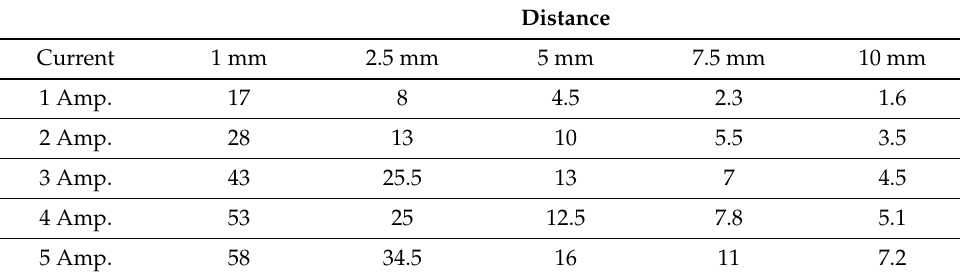
Table 3. Magnetic fields generated (mT) in the region of interest for different currents.